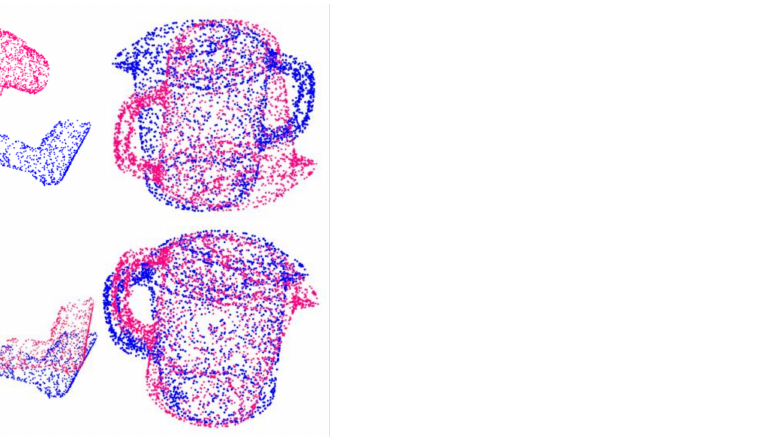
Figure 8. Initial estimated pose and fine adjusted pose of the example input point cloud. The blue point cloud represents the real pose of the target, and the red point cloud represents the estimated pose. The upper row objects are the result of the training of the previous modulation network that still has a certain error with the real value. The lower row is the result of fine-tuning network training, which obviously improves the accuracy of estimation effectively.